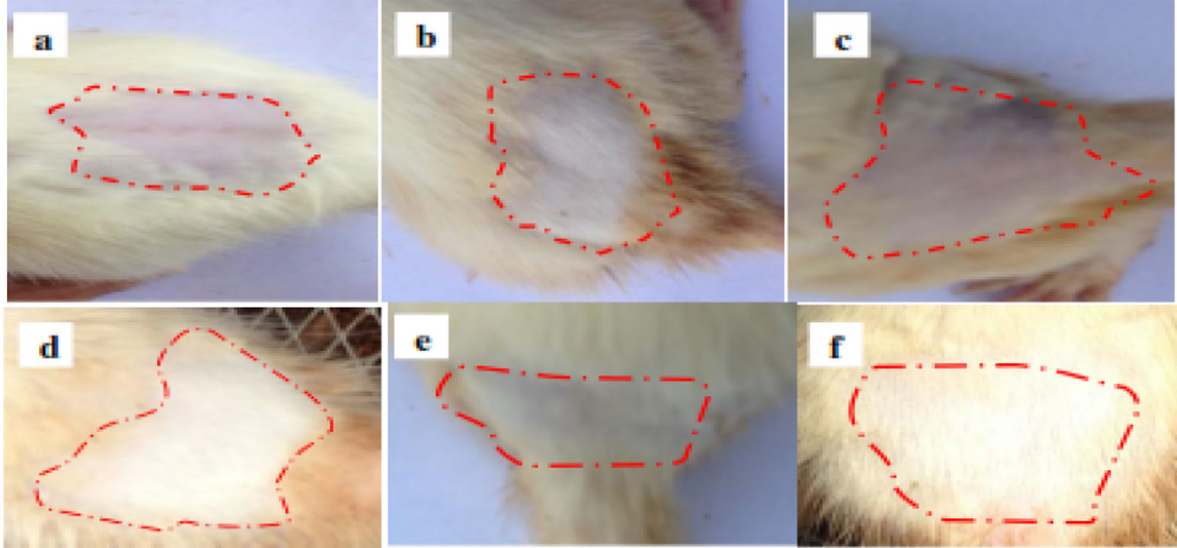
Fig. 7 a , c and e : are the pre-treatment at 0 day while b , d and f are the post-treatment of control, Sesamum indicum oil based nanoemulsion (SOAB) and Ciprofloxacin-loaded Sesamum indicum oil based nanoemulsion (SOAB